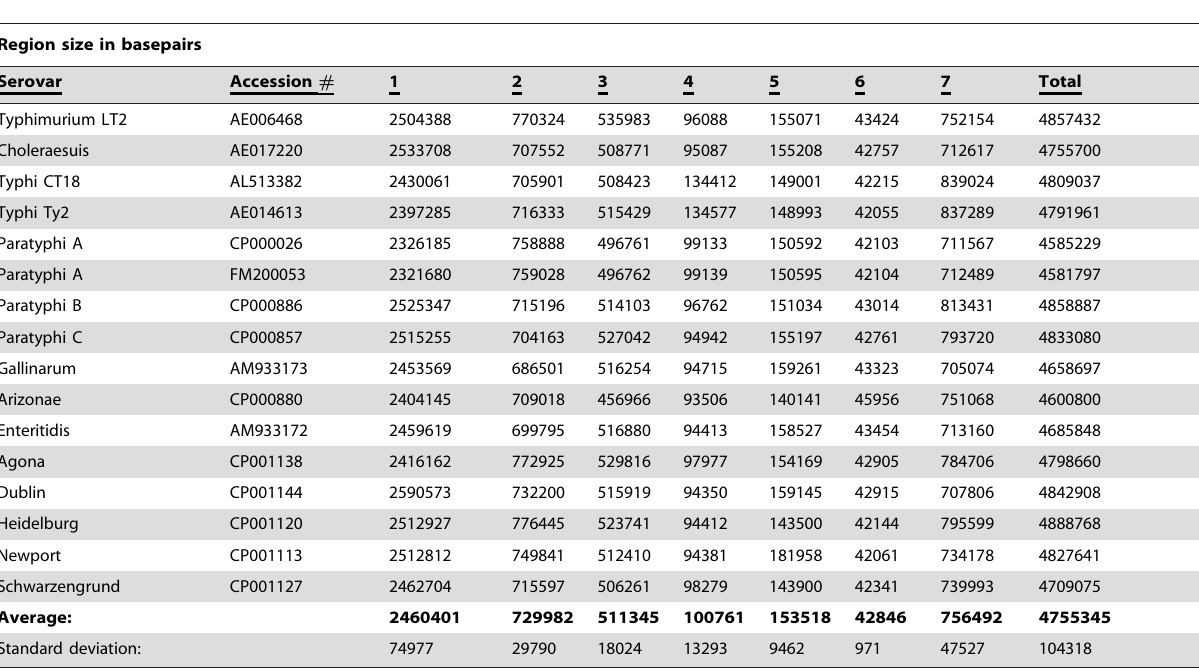
Table 3. Size of regions between rrn operons of sequenced Salmonella